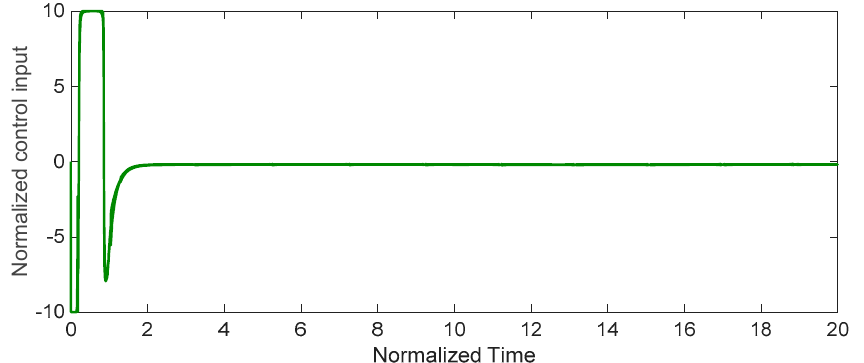
Figure 7. The control input of the closed-loop system based on the proposed control scheme in the